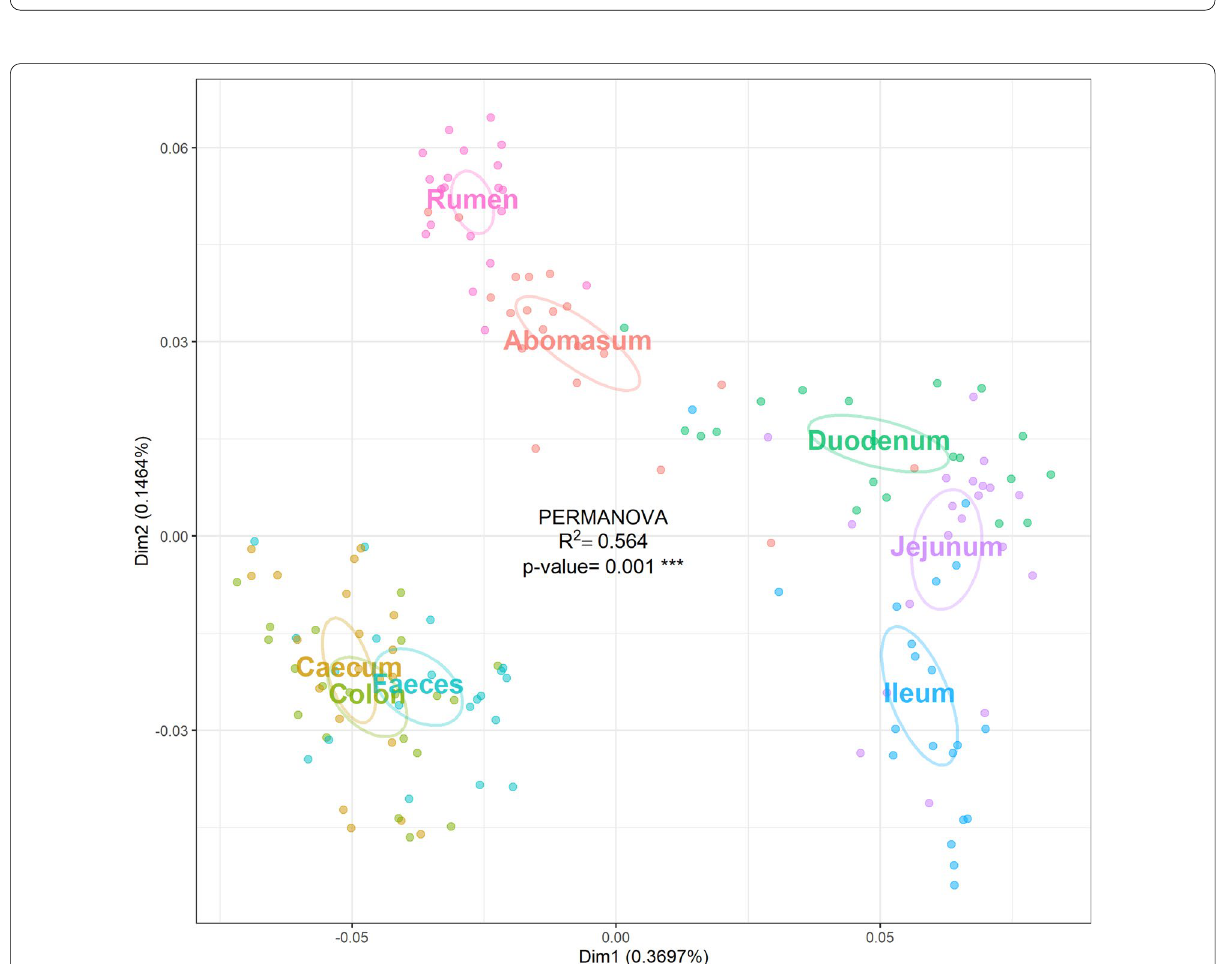
Fig. 2 Principal coordinates analysis (PCoA) based on weighted UniFrac distance matrix of samples collected along the gastro-intestinal tract (GIT) of High- and Low-FEC